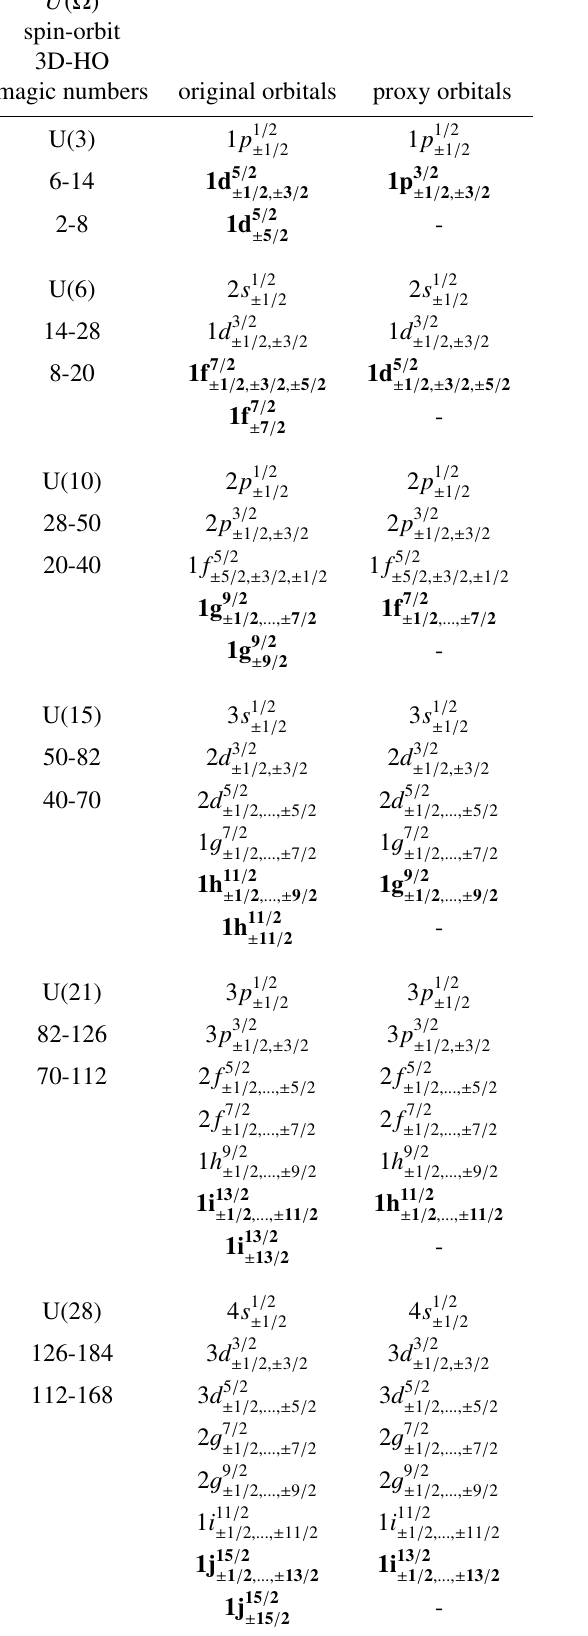
Table 3. The shell model orbitals of the original spin-orbit like shells and of the proxy-SU(3) shells. The magic number 14 is proposed as a sub-shell closure in Ref. [84]. The symmetry of each proxy-SU(3) shell is U( Ω ) with Ω = ( N + 1)( N + 2) . The 2 orbitals being replaced are denoted by bold letters. Adapted from Ref. [83].